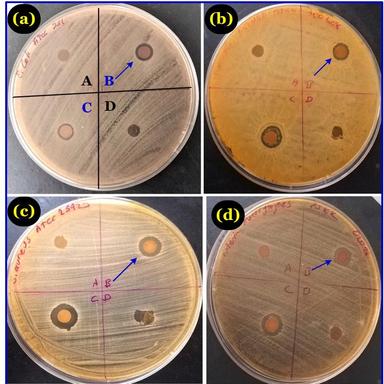
Digital photos of the antibacterial property of various as-prepared films: (a) Escherichia coli, (b) Salmonella enterica subp. enterica, (c) Staphylococcus aureus, and (d) Listeria monocytogenes.